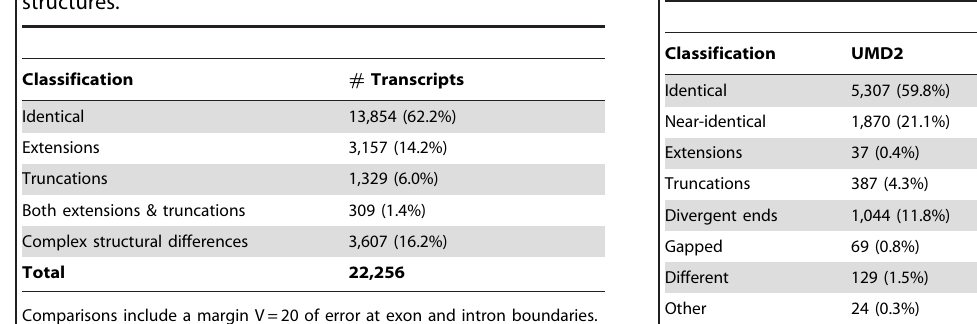
Table 3. Comparison of predicted protein translations to RefSeq protein